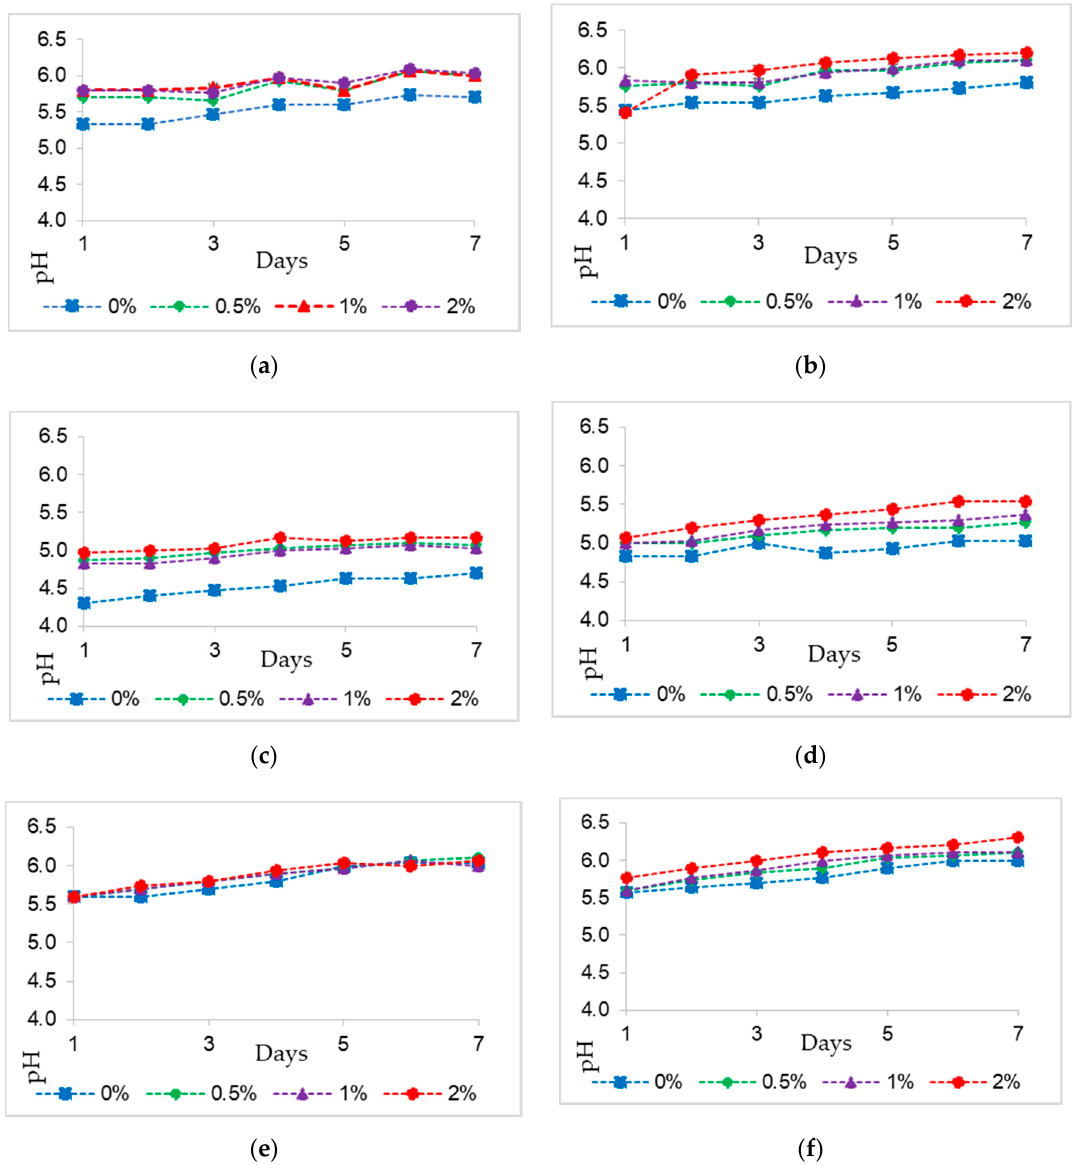
Figure 7. Temporal effect of biochar on pH: ( a ) topsoil with granular biochar; ( b ) topsoil with powder biochar; ( c ) E-horizon soil with granular biochar; ( d ) E-horizon soil with powder biochar; ( e ) mixed soil with granular biochar; ( f ) mixed soil with powder biochar.